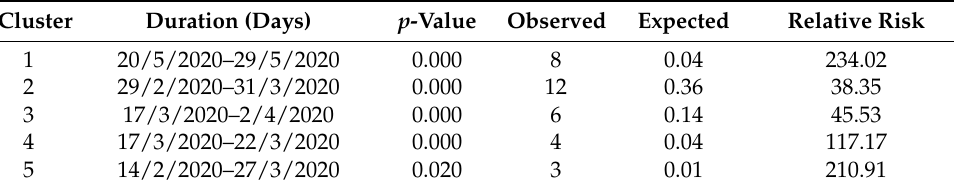
Table 3. Space–time clusters in stage I of COVID-19 transmission in residential locations in Hong Kong. Cluster